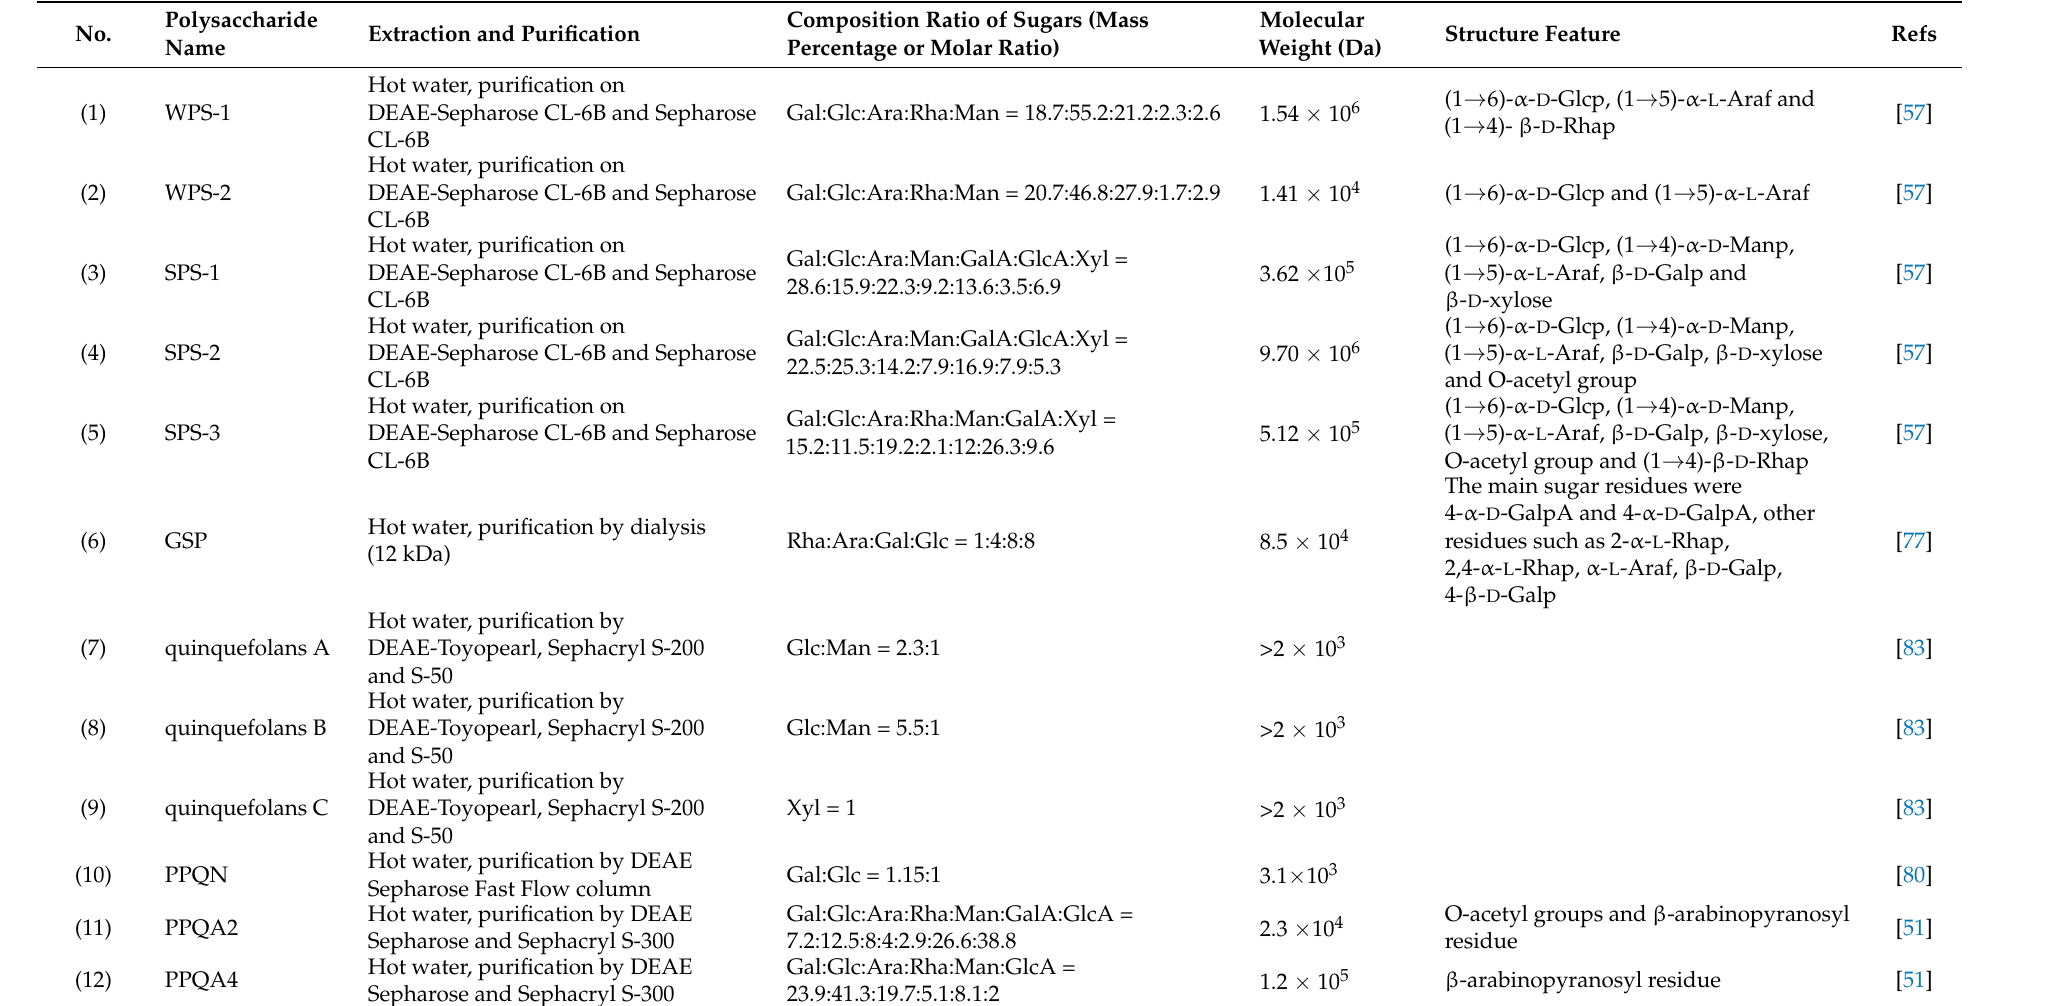
Table 2. Structure and composition of American ginseng